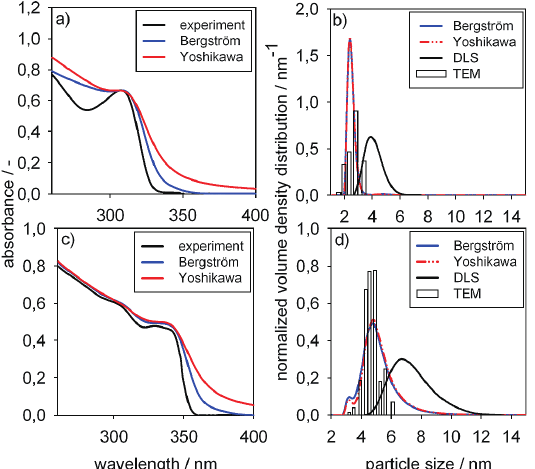
Fig. 7 Comparison between the calculated PSDs, DLS and optical image analysis of two different samples of b) small and d) large ZnO QDs and the related measured (black solid line) and reconstructed (blue and red solid lines) absorbance spectra for a) smaller and c) larger- sized samples. Reprinted with permission from Segets et al., “Analysis of Optical Absorbance Spectra for the Determination of ZnO Nanoparticle Size Distribution, Solubility, and Surface Energy” ACS Nano 2009 3(7), p. 1703–1710. Copyright 2009 American Chemical